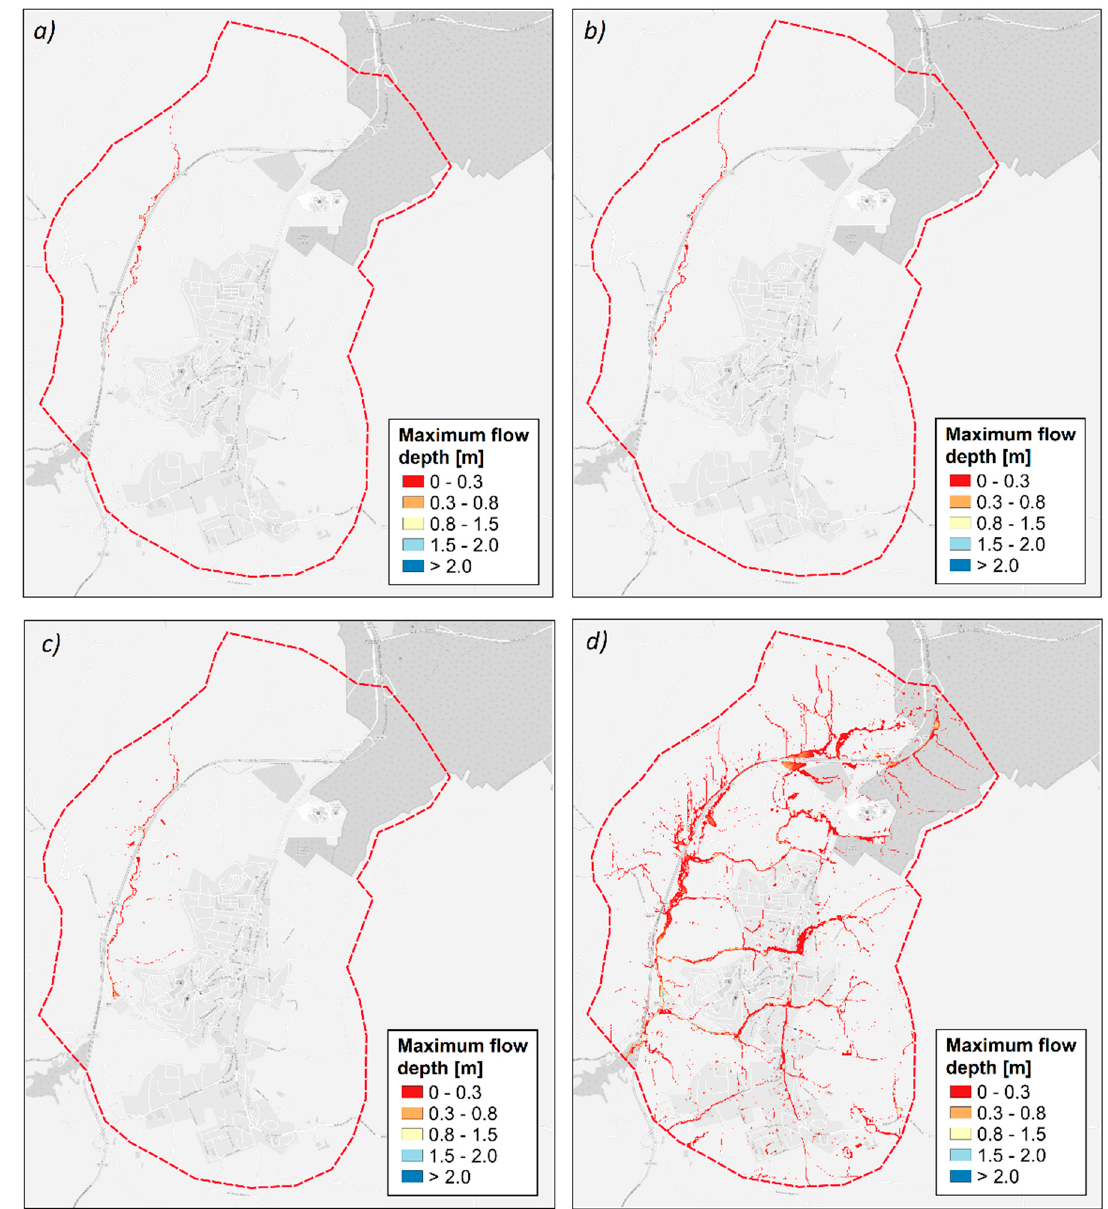
Figure 4. Maximum flow depth for the 2010 scenario: ( a ) T = 2 years; ( b ) T = 5 years; ( c ) T = 10 years; and ( d ) T = 20 years.